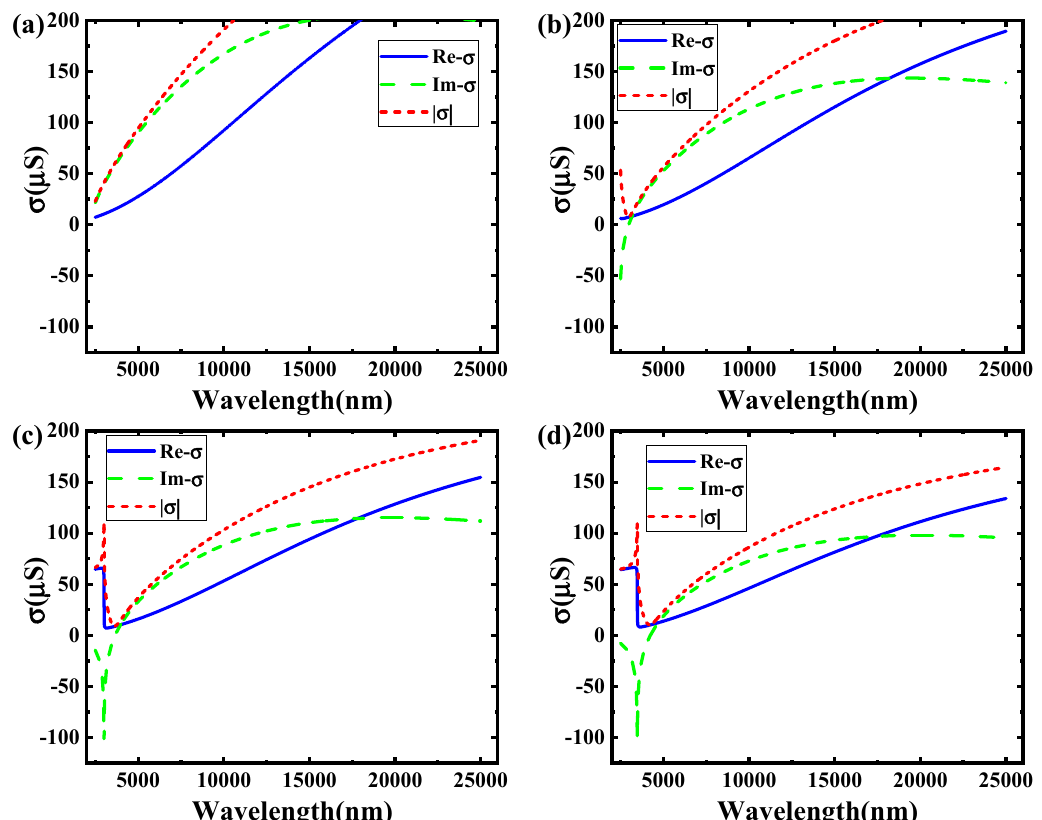
Figure 5. The image of conductivity as a function of incident wavelength in different substrate thicknesses. ( a ) 5 nm; ( b )10 nm; ( c ) 15 nm; ( d ) 20 nm.